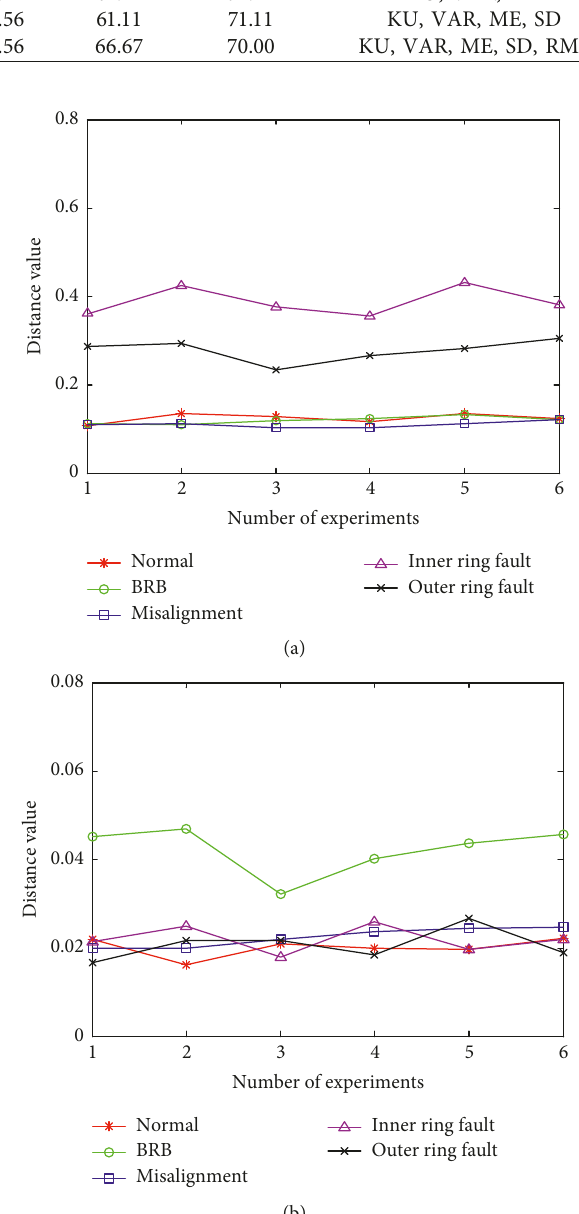
Figure 17: Distance of the SVM with (a) vibration data and (b) current